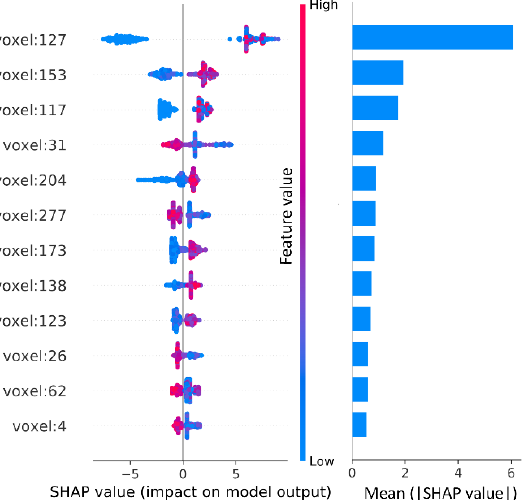
Figure 6. Summary plots ( left ) and feature importance ( right ) of 12 important voxels. The summary plots are a set of beeswarm plots where each row represents a feature and each point corresponds to a subject. The position of the points on the x-axis shows the effect of the feature on the age prediction of the subject. When multiple points fall at the same x position, they stack up vertically to show density. Here the feature values indicate the amount of GMV. The bar chart on the right represents the importance of each feature, and each bar is the average of all SHAP absolute values in the corresponding row.